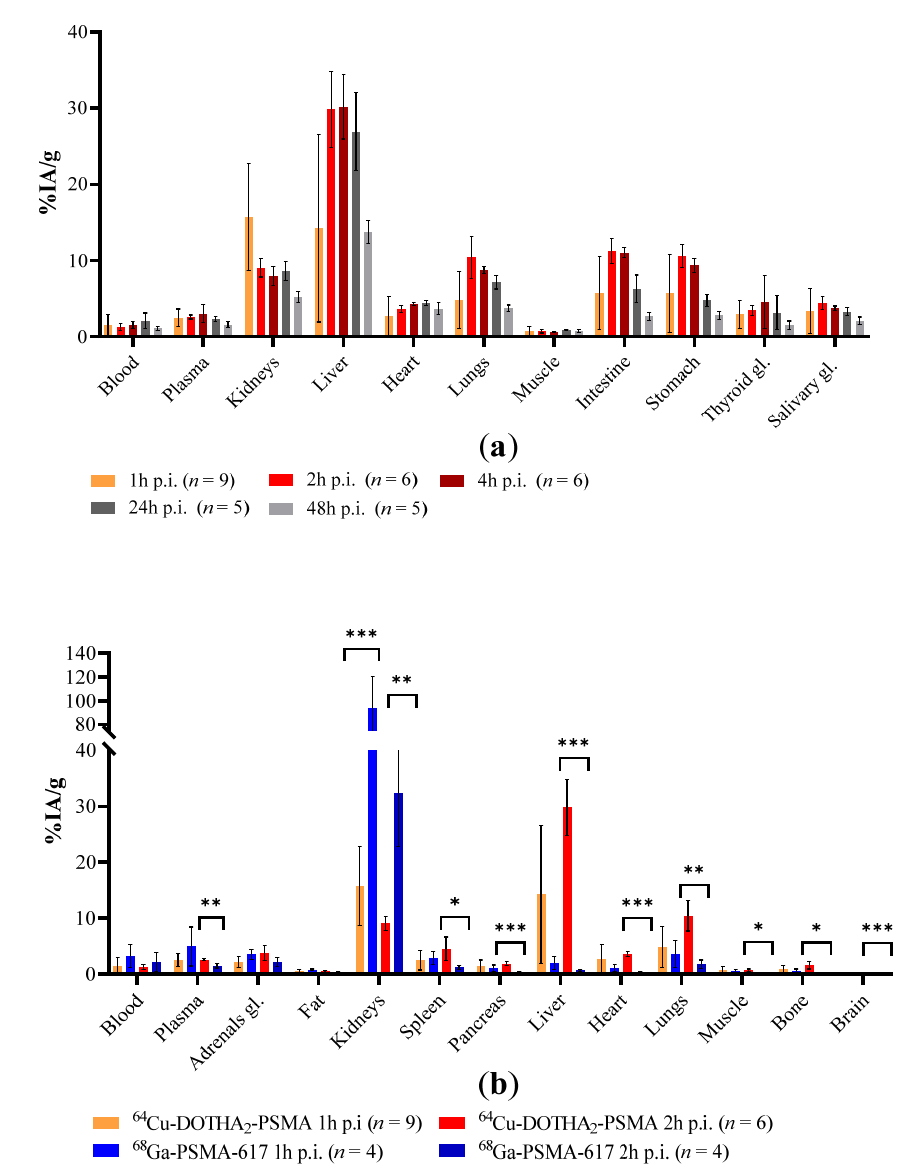
Figure 2. ( a ) 64 Cu-DOTHA 2 -PSMA biodistribution of non-tumor-bearing balb/c mice up to 48 h p.i. and ( b ) in comparison with 68 Ga-PSMA-617. Complete, numerical data are presented as Supplementary Materials. For clarity, only significant differences are shown in ( b ). *: p < 0.05, **: p < 0.01, ***: p < 0.001.